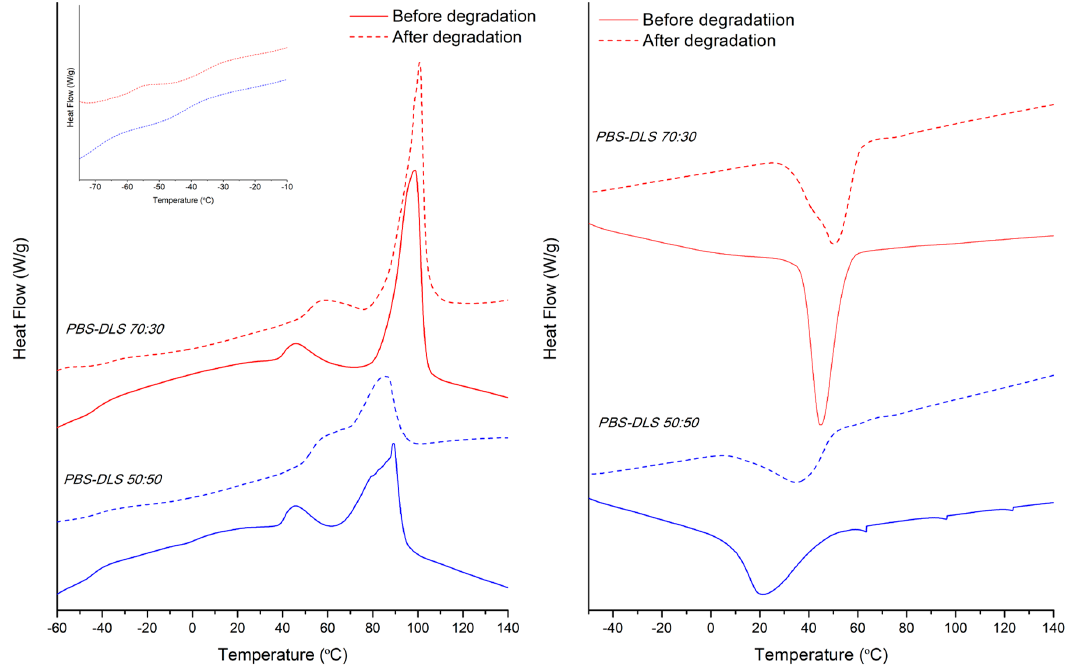
Figure 11. Left : First heating scan of fibers before (solid line) and after (dashed line) degradation with a T g region detail of degraded samples. Right : Cooling scan of fibers before (solid line) and after (dashed line) degradation. PBS-DLS 50:50 (blue) and PBS-DLS 70:30 (red) copolymers.